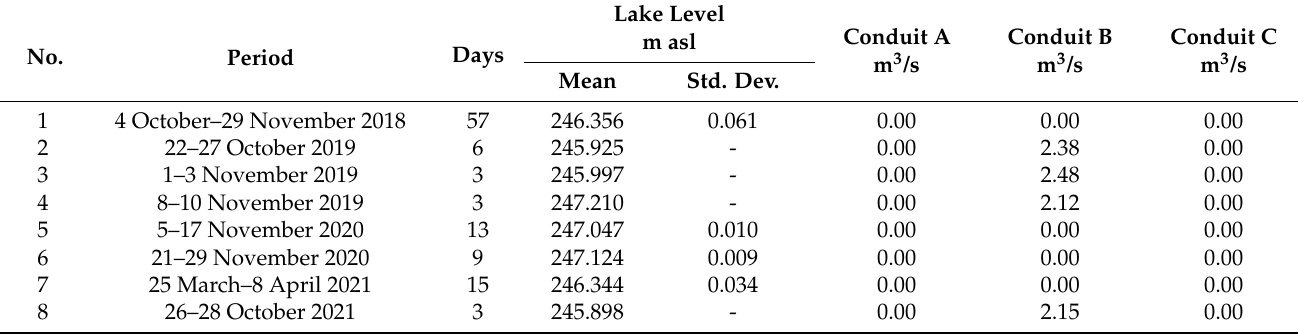
Table 1. Periods, day length, lake level, and inflow and outflow for calculating the net groundwater inflow G.